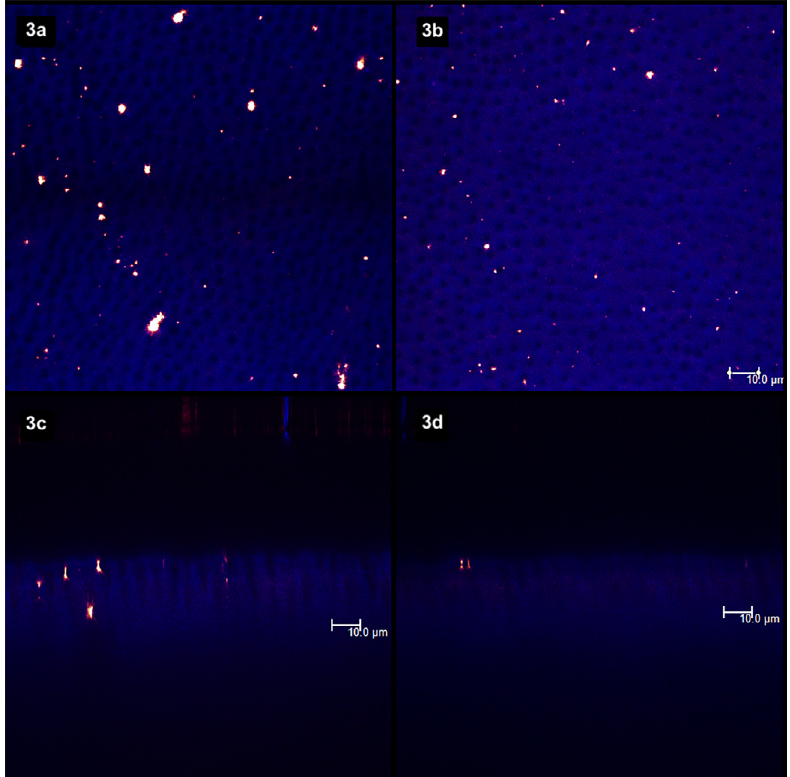
Figure 3- After the application of a toothpaste without S-PRG fillers, the dentin surface (3a) and the aperture of dentinal tubules (3c) presented few solid deposits, which were almost completely removed from the surface (3b) and from the tubules (3d) after the erosive